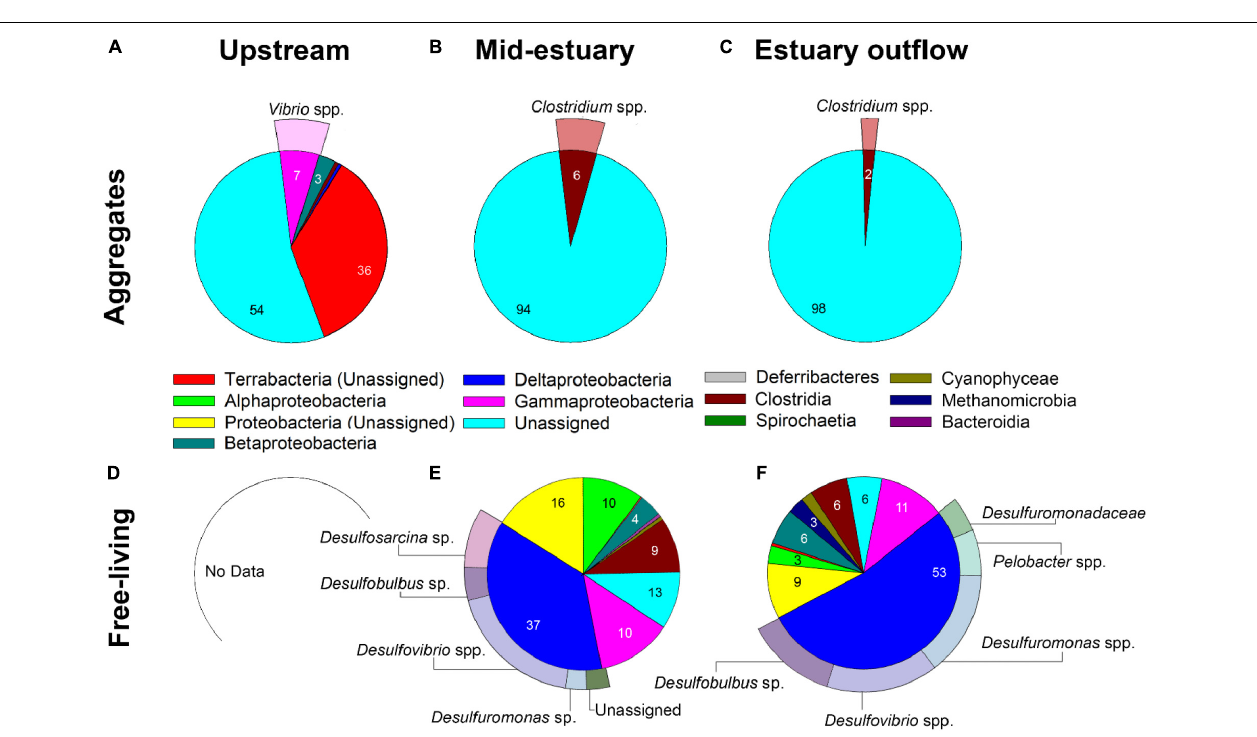
FIGURE 4 | Principal coordinate analysis (PCoA) plots showing the distance in bacterial diversity (derived from nif H analyses) using weighted UnifFrac at the different sampling locations (A) and sampling seasons (B) . Colors represent free-living (yellow) and aggregate-associate (blue) fractions. The shapes of the symbols in the figure (A) indicate the different sampling locations; upstream (circle), mid-estuary (triangle) and estuary outflow (square). Shapes of the symbols in figure (B) indicate the summer (star) and winter (diamond).